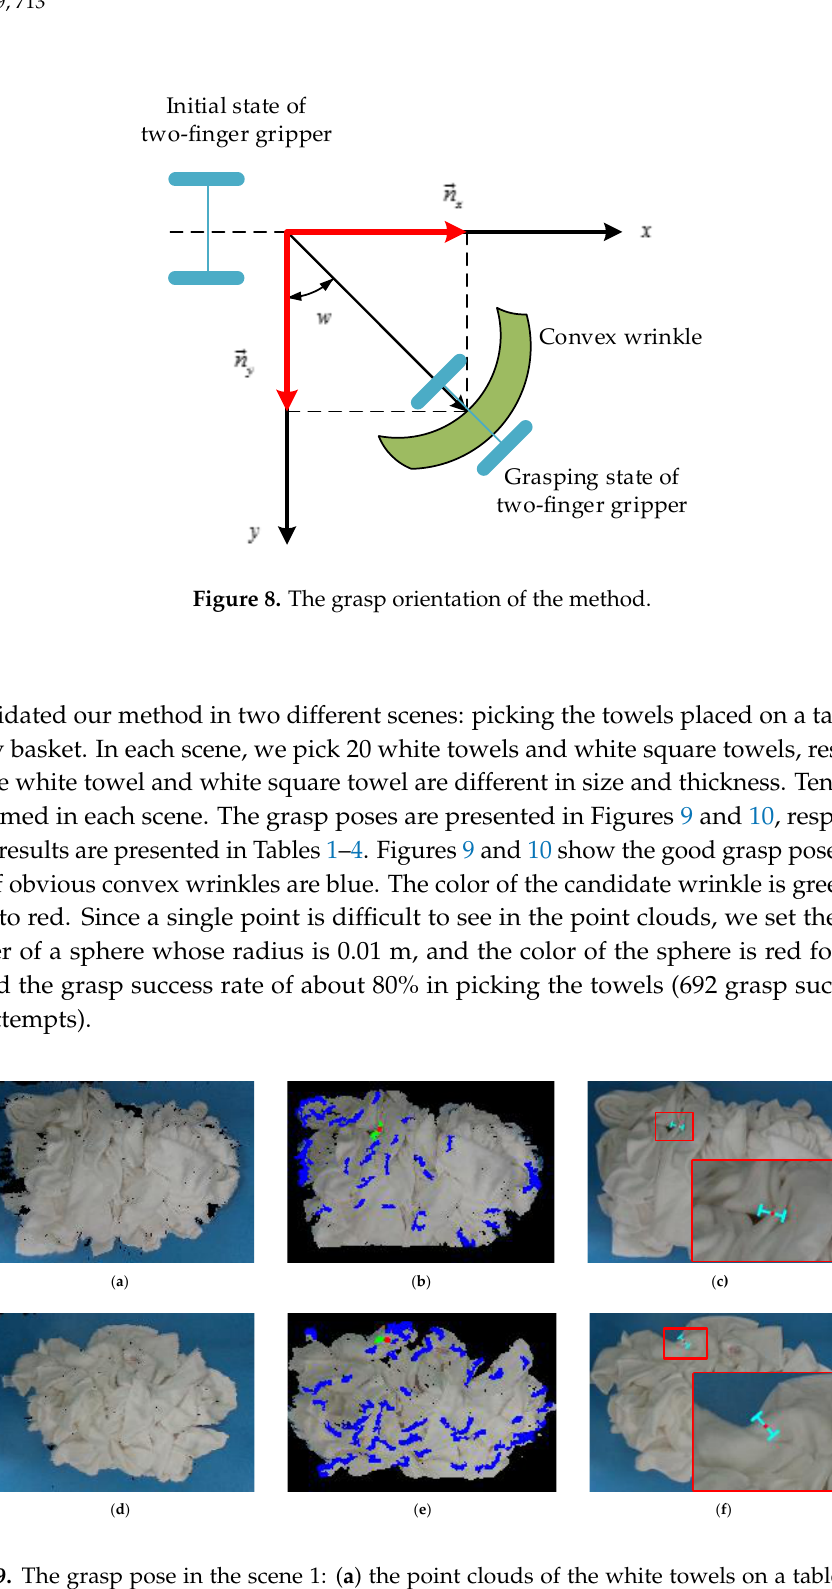
Figure 9. The grasp pose in the scene 1: ( a ) the point clouds of the white towels on a table; ( b ) the grasp point on the candidate convex wrinkle; ( c ) the projection of a grasp pose on the image; ( d ) the point clouds of the white square towels on a table; ( e ) the grasp point on the candidate convex wrinkle; ( f ) the projection of a grasp pose on the